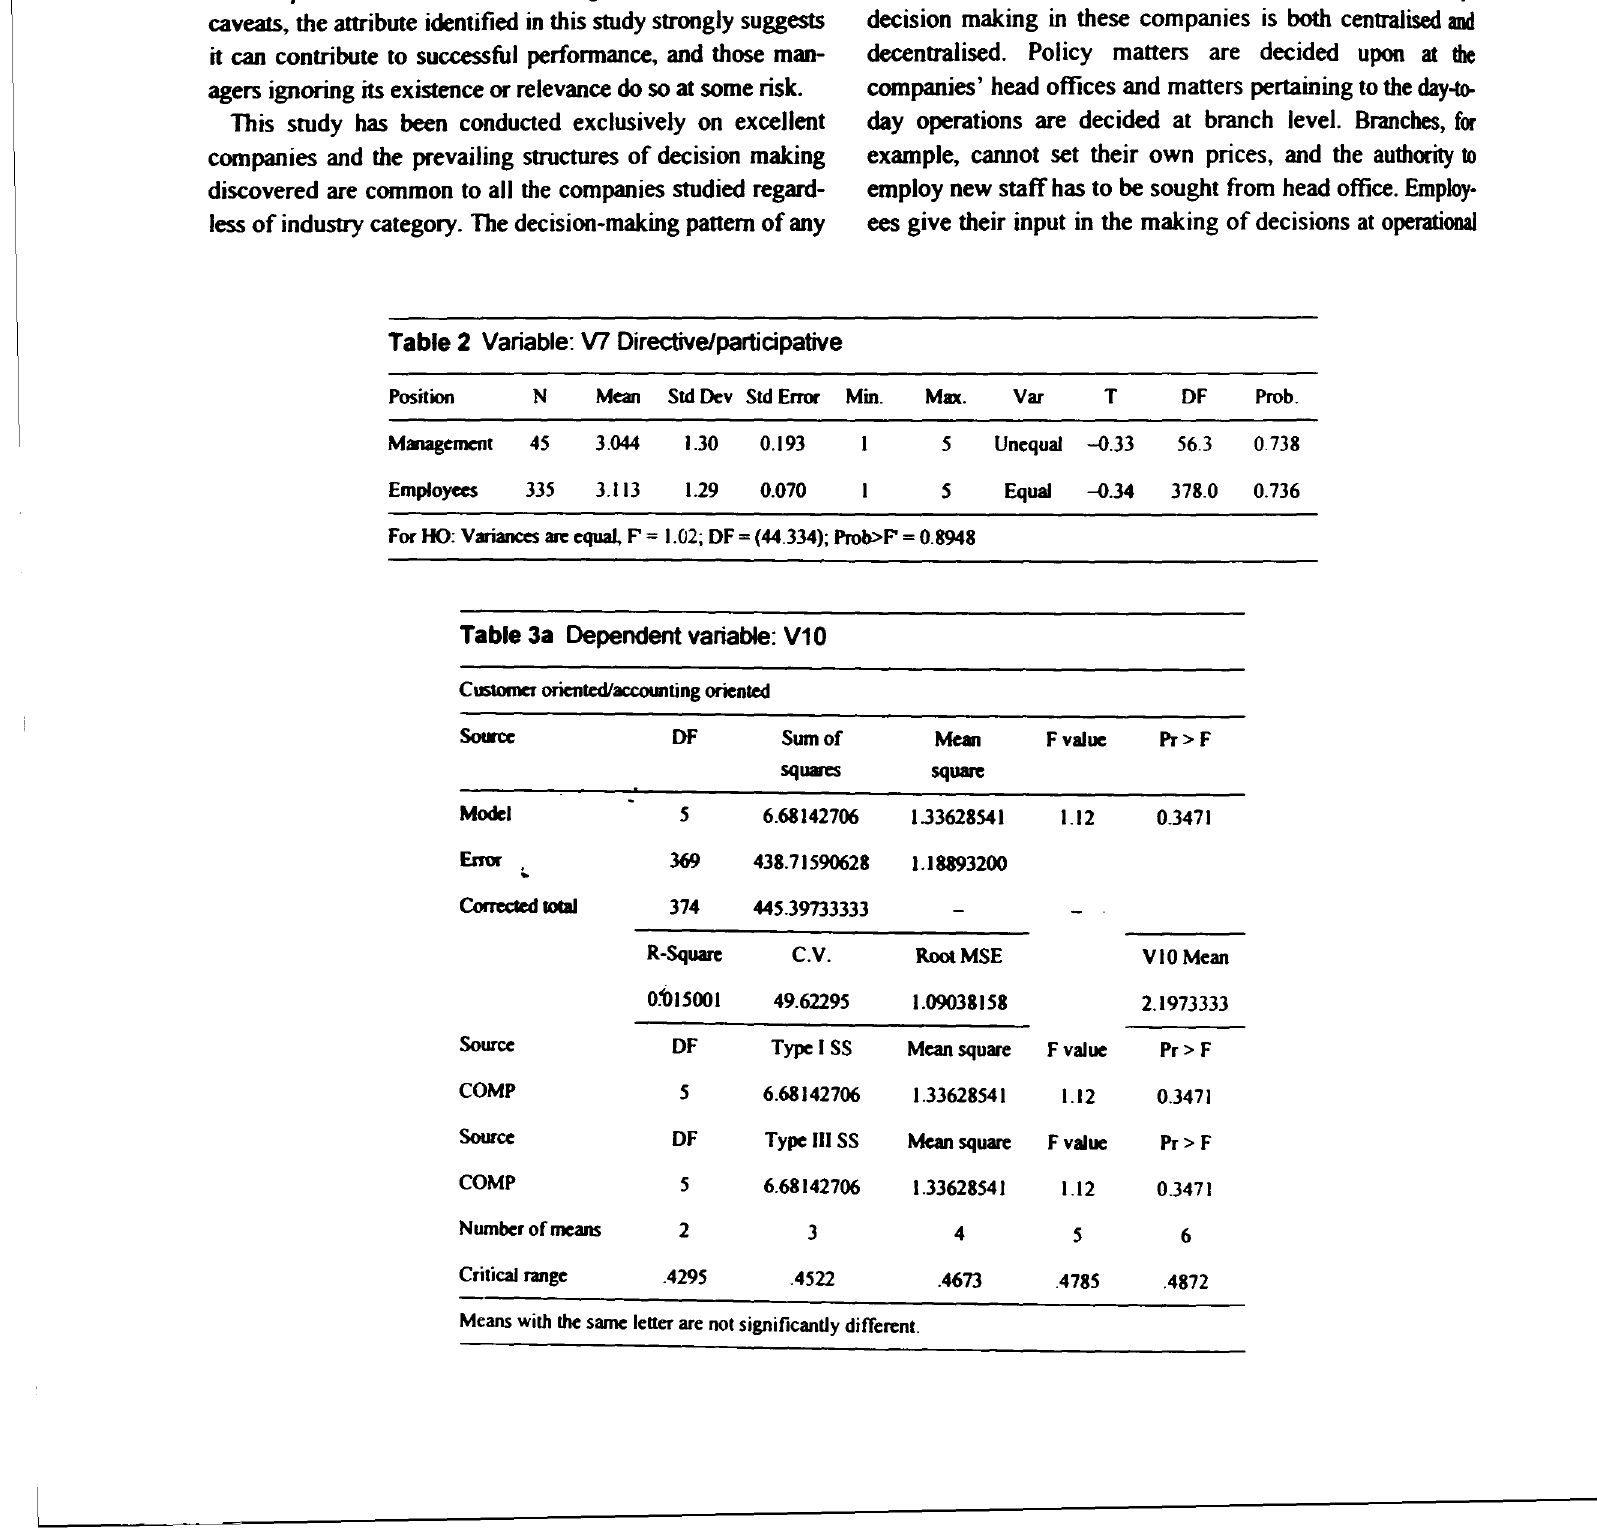
Table 2 Variable: V7 Directive/participative